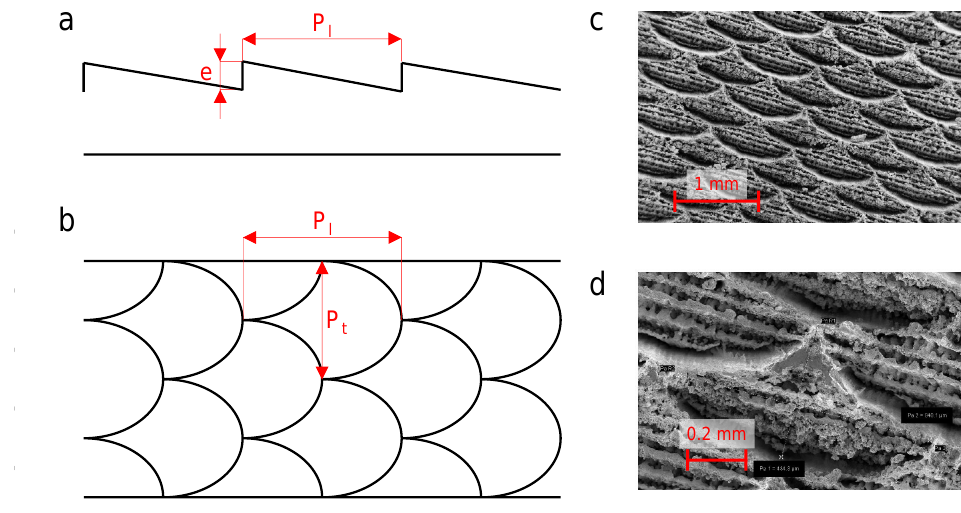
Figure 1. Elliptic scale-roughened patterns: ( a ) Schematics of the lateral and ( b ) top view of the elliptic scale roughened-surface (ESR) pattern. ( c ) Image of the laser-etched ESR pattern as obtained by field emission scanning electron microscopy (FESEM) at 100 × and ( d ) 350 × magnification: The FESEM pictures are provided by Microla Optoelectronics S.r.l., using 30 µ m aperture size, 5 mm working distance, and 5 kV electron high